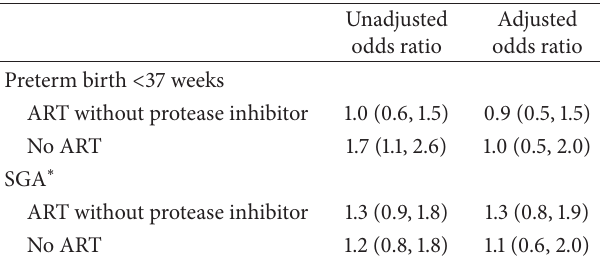
Table 4: Unadjusted and adjusted odds ratios for pregnancy outcomes in HIV-infected women according to type of antepartum antiretroviral